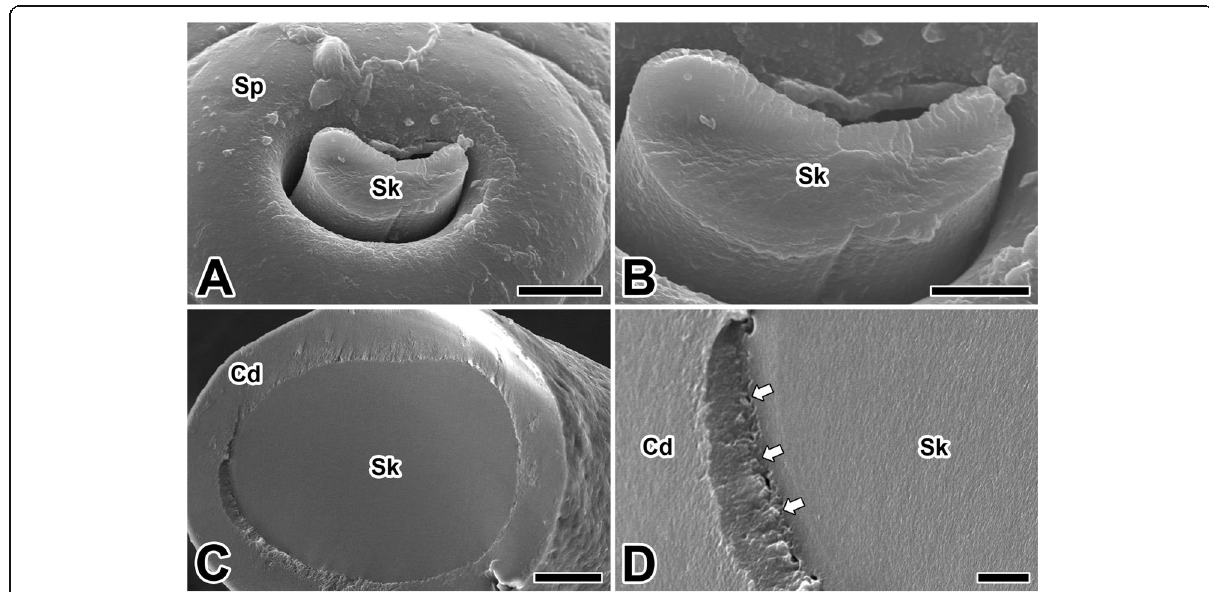
Fig. 2 a - d Scanning electron micrographs of the spinneret (Sp) and silk fiber (Sk) of the caddisworm H. nigrovittatus. Sp: spinneret. Arrows indicate the marginal area between the cuticular duct and luminal silk material. Scale bars indicate 25 μ m ( c ), 10 μ m ( a ), and 5 μ m ( b, d ), respectively